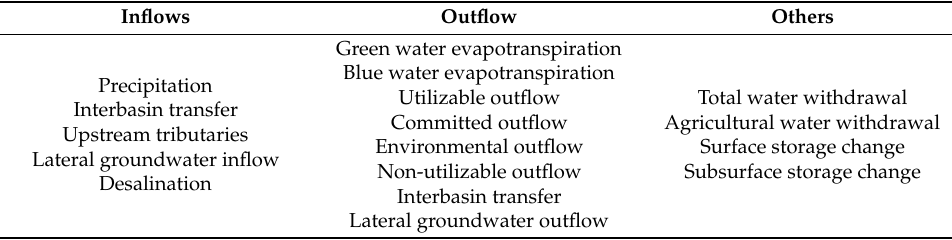
Table 1. The main components of the resource base